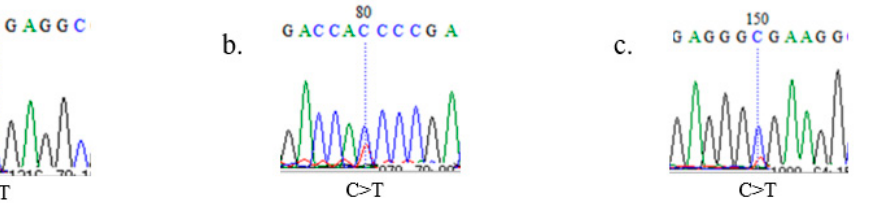
Figure 2. Sequence results showing SOX10 single-nucleotide polymorphisms: ( a ) g.54065419; ( b ) g.54070844; ( c ) g.54070904. Table 3. Haplotype analysis of duck plumage color and reproductive traits. Means of Haplotypes of Reproductive Traits and Egg Quality